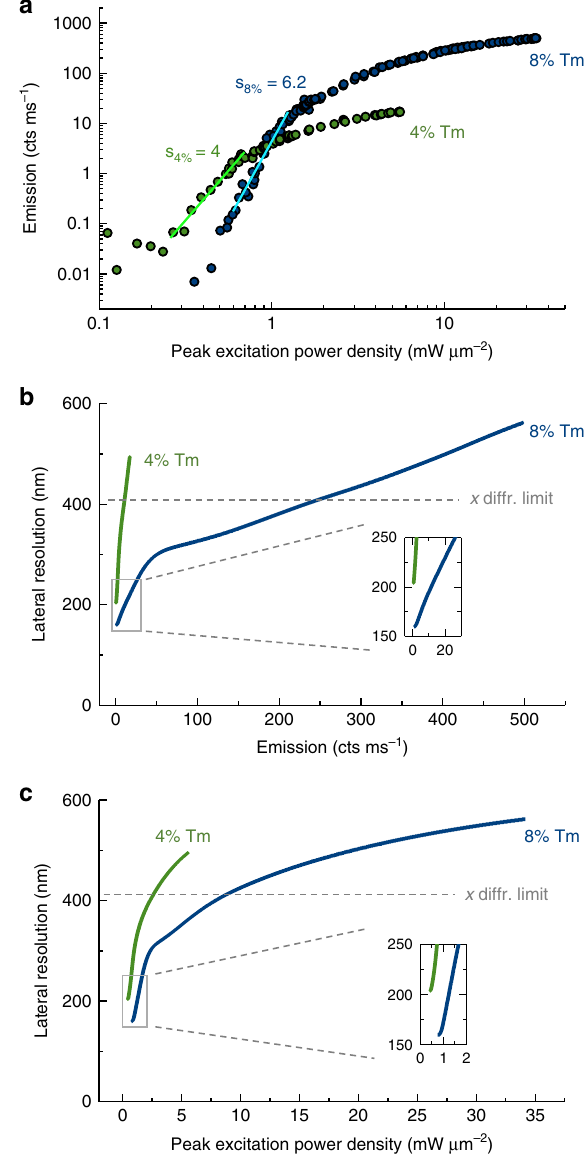
Fig. 4 High (8%) Tm doping in UCNPs improves uSEE microscopy performance. a The 8% Tm doped UCNPs have a steeper super-linear slope than the 4% Tm doped UCNPs. b The lateral resolution vs emission graph shows that while imaging at the same resolution, the 8% Tm doped particles have brighter emission. c The lateral resolution vs peak excitation power density graph shows that while imaging at the same excitation power, the 8% Tm doped UCNPs offer better lateral resolution. The data for 4% Tm-doped sample are marked in green and the 8% Tm-doped sample in